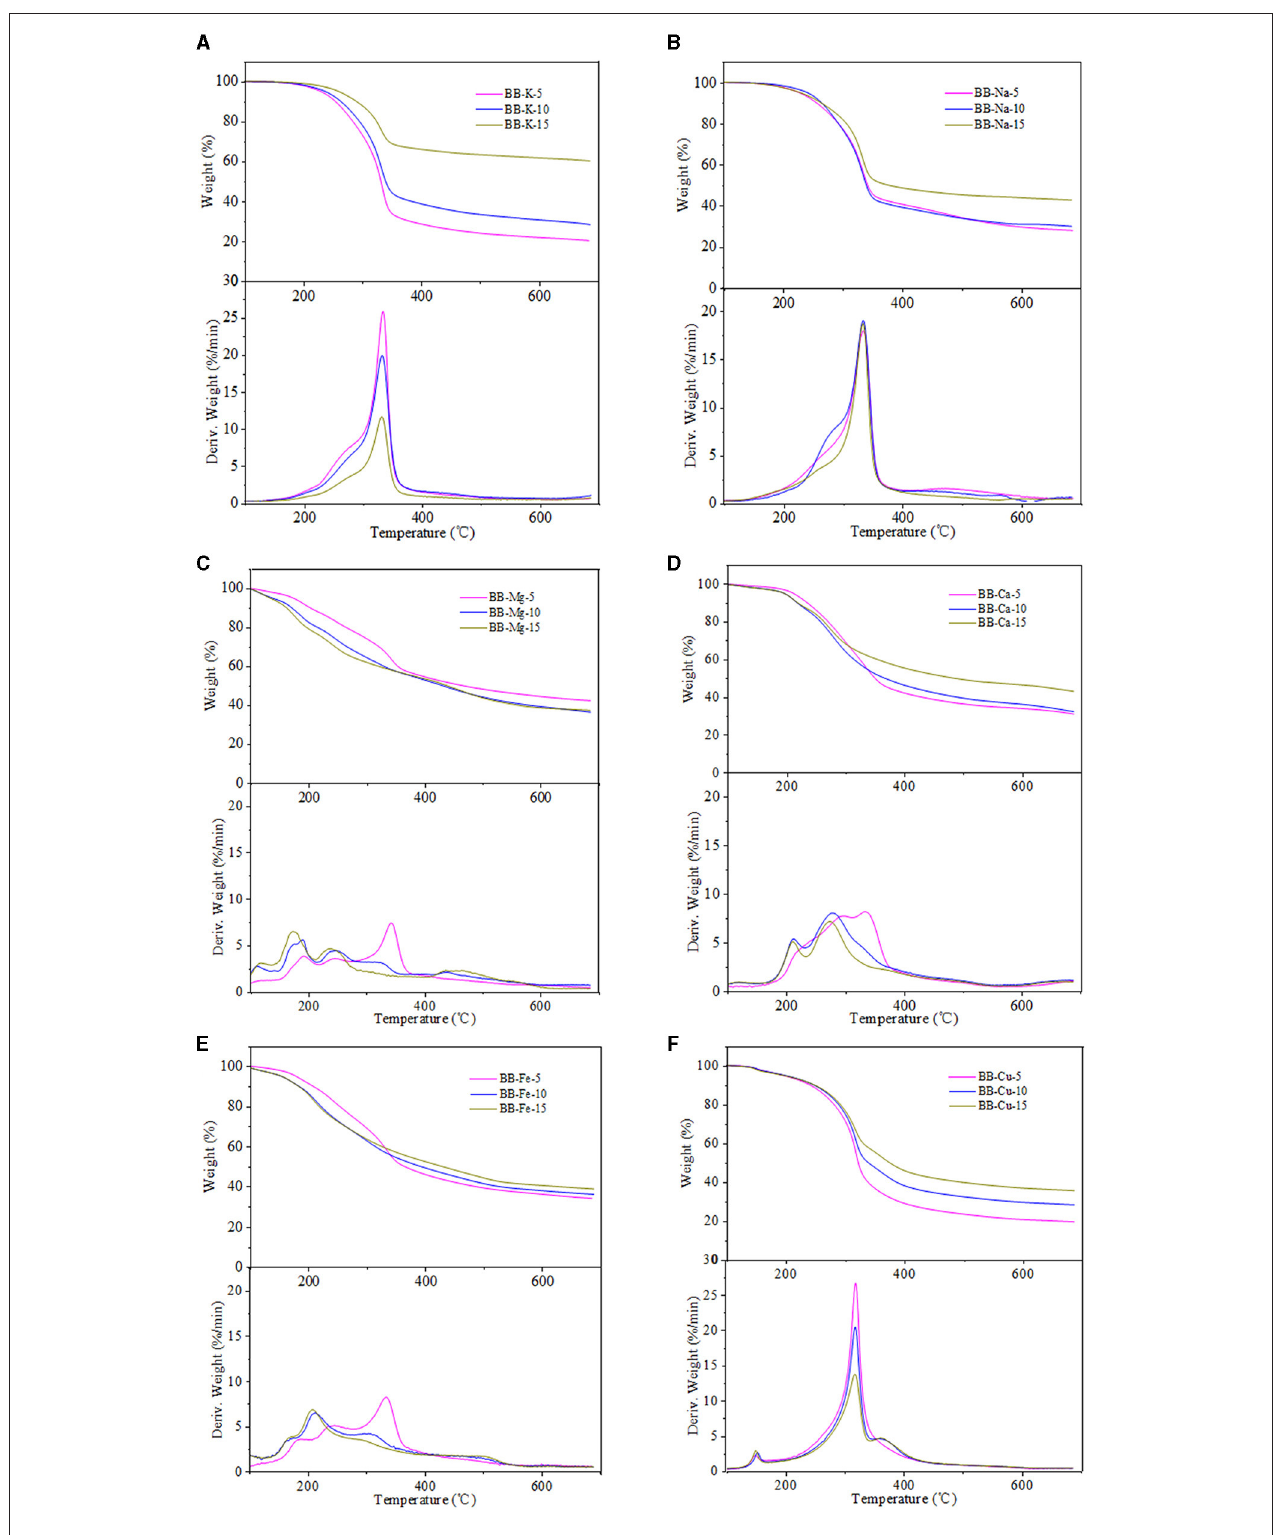
FIGURE 4 | (A–F) TG and DTG curves of metal loaded bamboo samples.